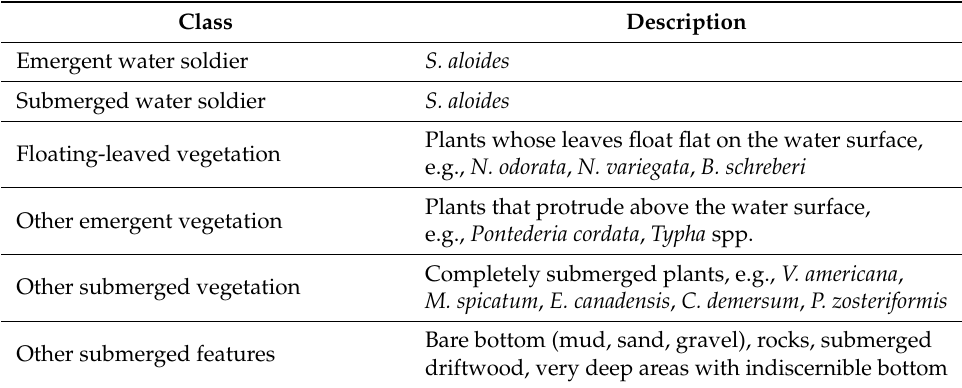
Table 1. Description of classes used in object classification. “Emergent” classes were used in the classification of above-water objects, “submerged” classes were used in the classification of submerged objects, and the floating-leaved vegetation class was used in both (see